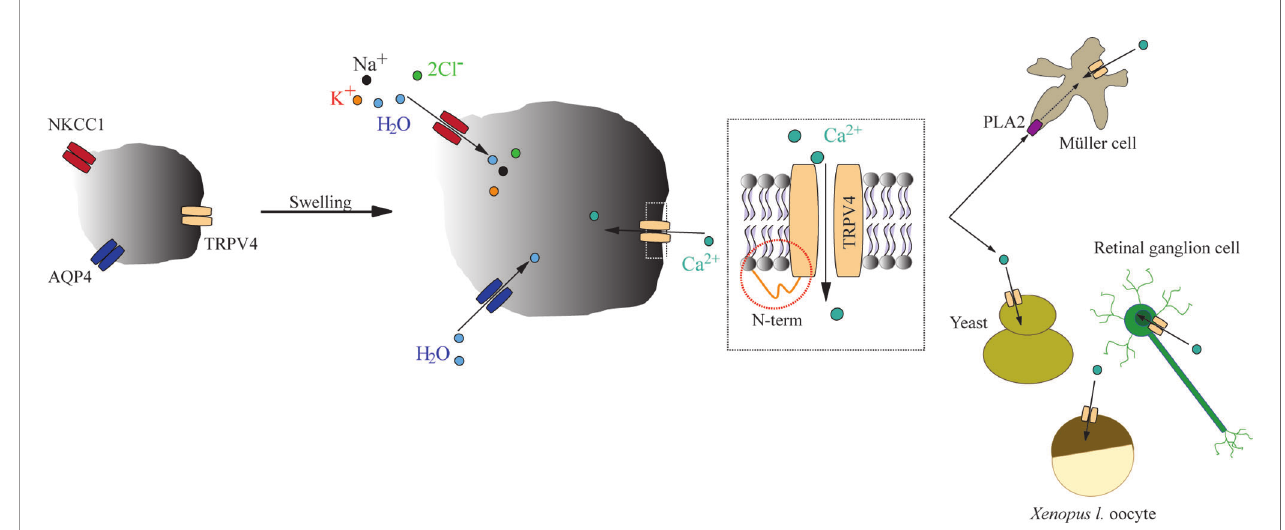
FIGURE 6 | A schematic depicting the mechanisms underlying swelling-induced TRPV4 activation. Increased cell volume activates TRPV4 irrespective of the molecular mechanism underlying the cell swelling. The TRPV4-mediated response to cell volume changes is dictated by its distal-most part of the N terminus, with cell-speci fi c requirement for PLA 2 activity as permissive for swelling-induced activation of